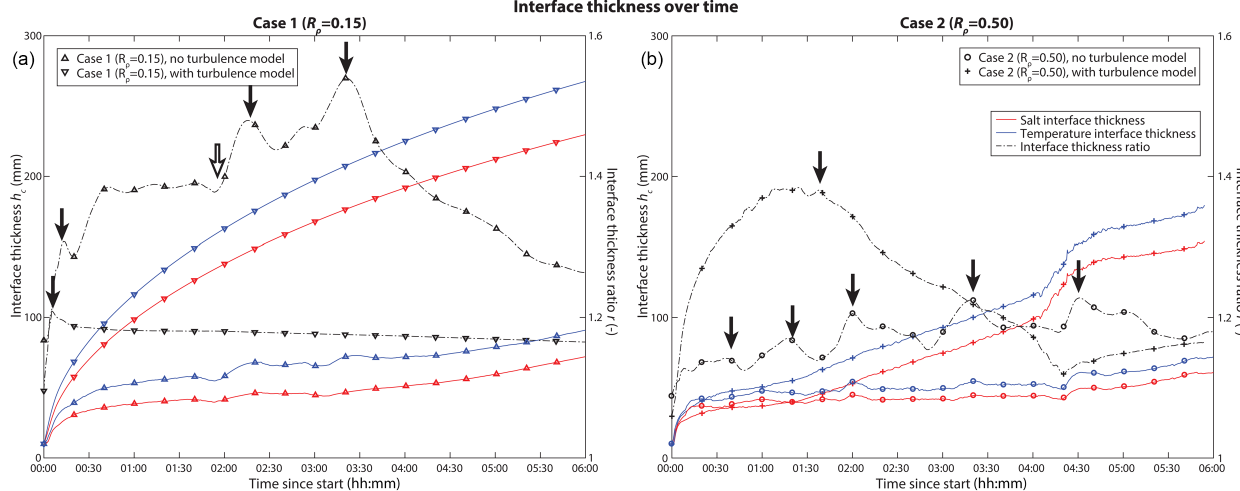
Figure 8. Time evolution of the interface thicknesses r for the depth profiles of S (red) and T (blue) and their ratios for R ρ and R ρ 0 . 50 (Case 2, b ). The interface thicknesses are averaged over the complete horizontal domain and each subplot presents the results = for the simulations with and without a turbulence model. The filled arrows mark clear drops of r , and the open arrow marks the moment that r starts its further increase in the direction of the theoretical interface ratio r